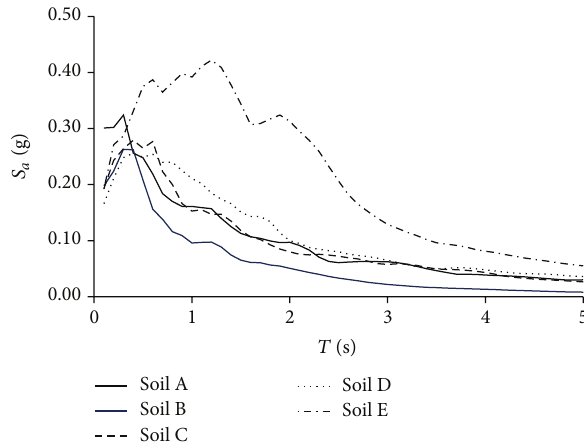
Figure 3: Average spectra for the selected ground motion records